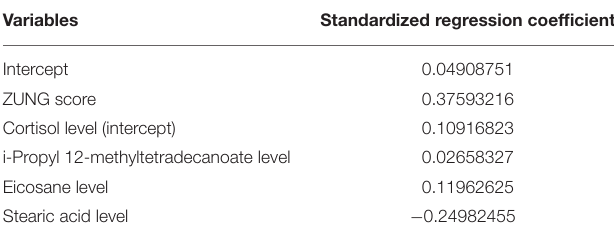
TABLE 2 | Standardized regression coefficient of variables. = − 1.714511 (dotted 1se )